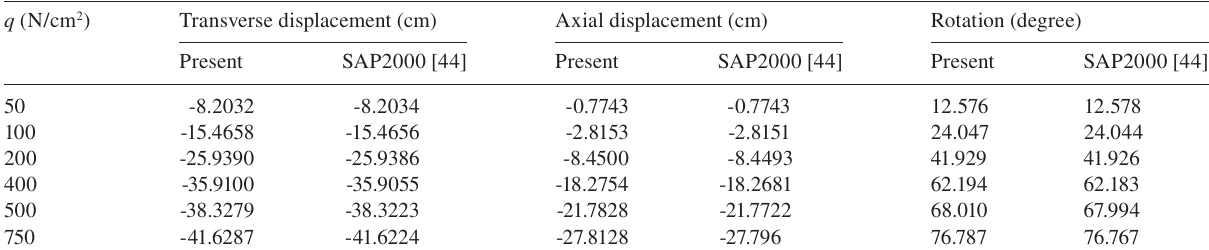
Table 4 Comparison of the present displacements and rotations at the free end for full metal cantilever beam under uniformly distributed load.